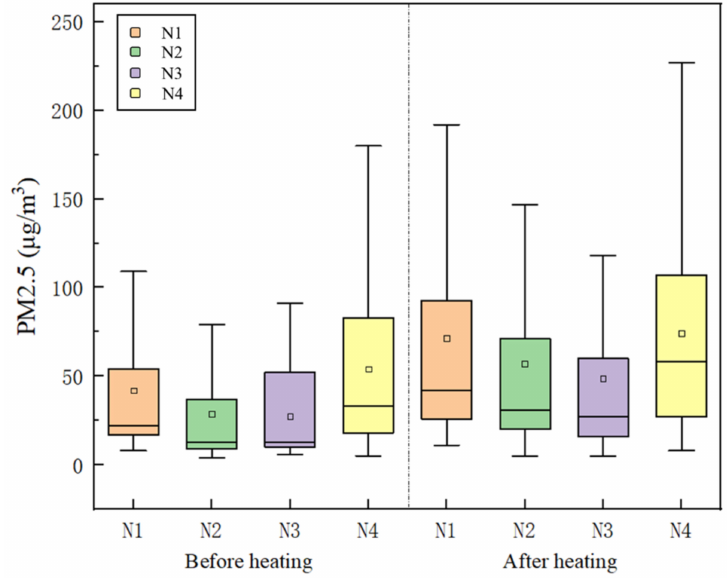
Figure 11. Box diagram of PM 2.5 .